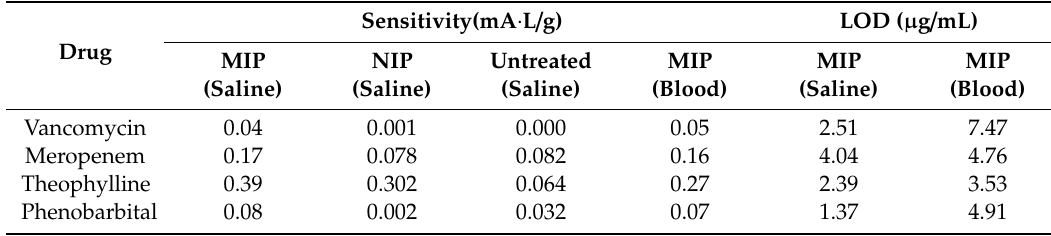
Table 3. Sensitivity and limit of detection (LOD) of MIP, NIP, and untreated electrode towards various